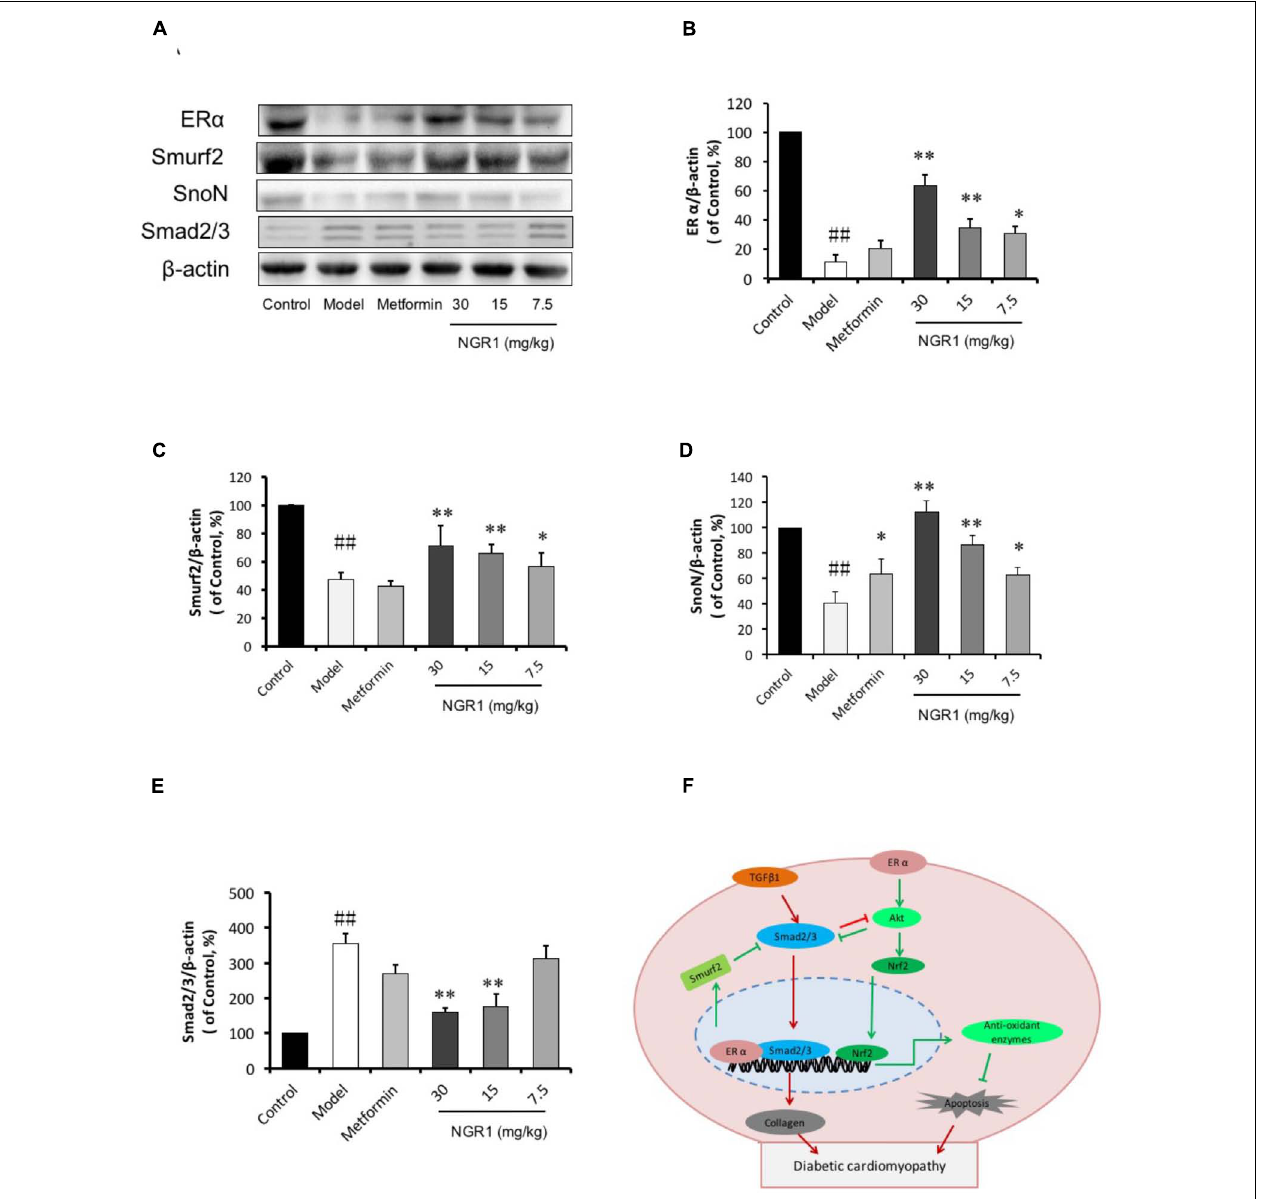
FIGURE 9 | NGR1 inhibits Smad2/3 expression by promoting Smurf2 expression in an estrogen receptor α -dependent manner. (A) Representative images of ER α , Smurf2, SnoN, and Smad2/3 protein expression determined by western blot. (B–E) The relative expression levels of ER α , Smurf2, SnoN, and Smad2/3 compared to β -actin are expressed in the bar graphs. The quantitative data are presented as the mean ± SD ( n = 3). ## P < 0.01 vs. the Control group, ∗ P < 0.05 or ∗∗ P < 0.01 vs. the Model group. (F) Schematic illustration showing the mechanisms underlying the prevention of diabetes/AGEs- induced injury in cardiomyocytes and db/db mice by NGR1. ER α , estrogen receptor α ; TGF- β , transforming growth factor β ; Smurf2, Smad-mediated ubiquitination regulatory factor 2; Nrf2, nuclear factor erythroid 2-related factor 2; Akt, protein kinase B.